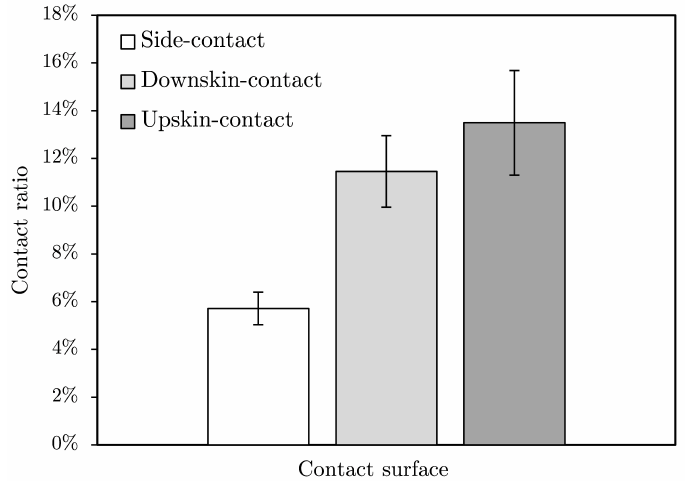
Figure 14. Contact ratio for different printing